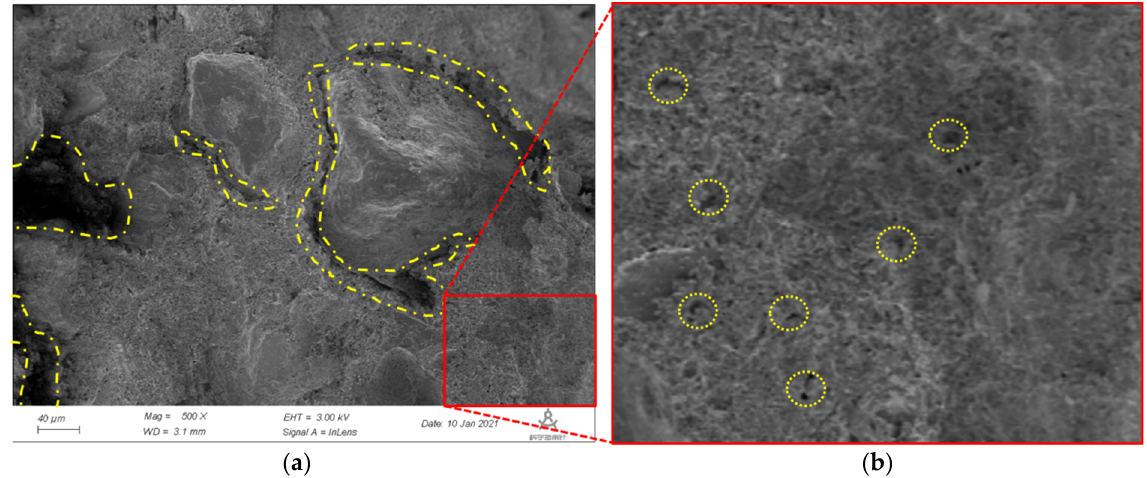
Figure 4. ( a ) The broken lines show the cracks that had penetrated. ( b ) The small circles show a small void that had not yet penetrated.